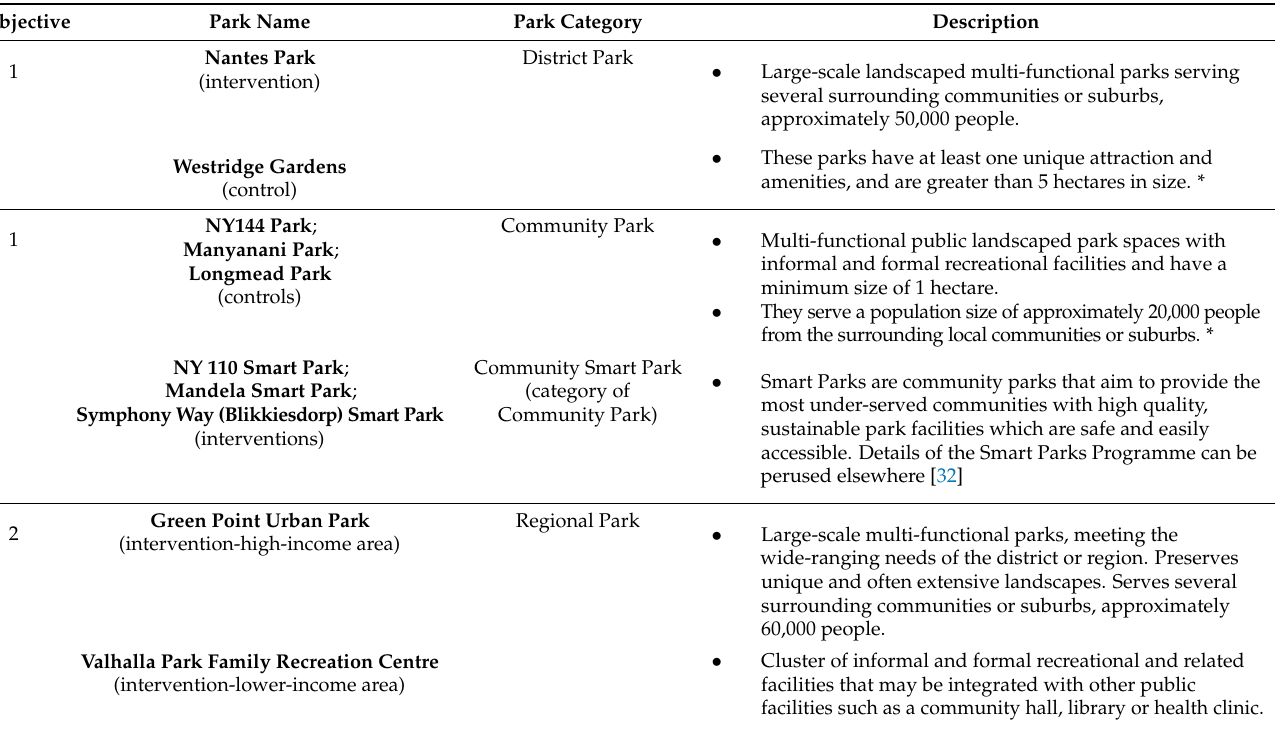
Table 1. City of Cape Town Park